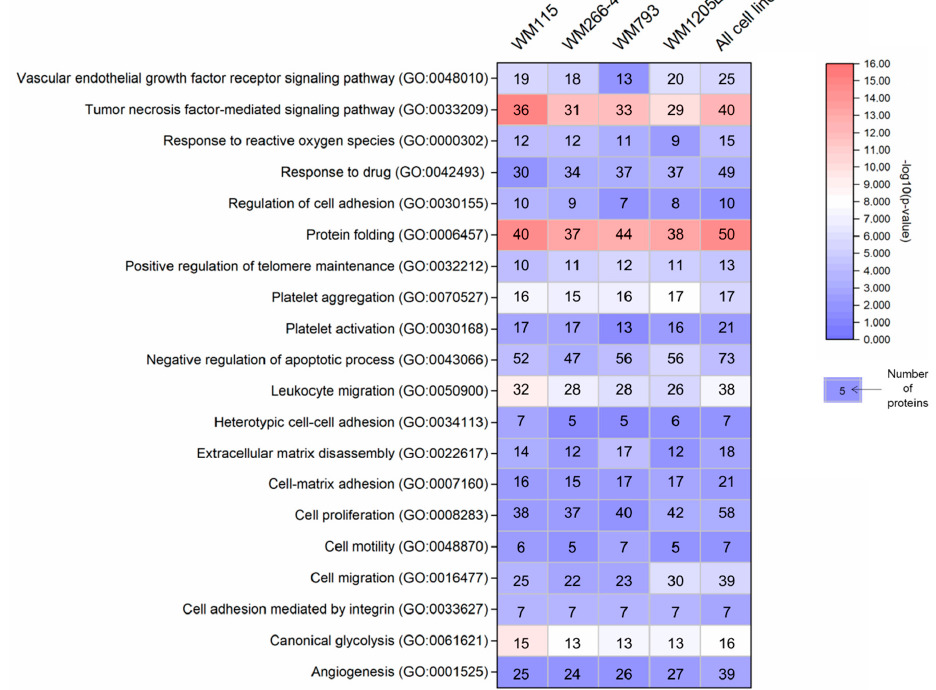
Figure 4. Gene ontology annotations by the biological process for each CM ectosome sample performed with the use of FunRich 2.0 software via UniProt (release 2019_11) database. Numbers of proteins within the chosen cancer-related categories (with statistical significance of protein enrichment within the given category calculated as -log10( p value)) are shown on the heat map. Ectosomes were isolated from WM115 (primary) and WM266-4 (metastatic) cell lines originating from the same individual, radial/vertical growth phase and lymph node metastasis, respectively; primary WM793 cell line, representing vertical growth phase; and WM1205Lu, a metastatic variant of WM793 cells obtained from lung metastasis.